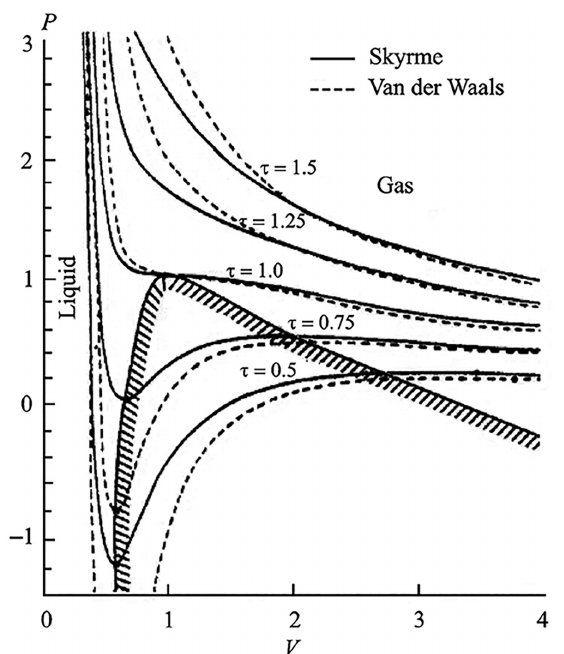
Figure 6. Equations of state P ( V ) for a nuclear system interacting through a Skyrme potential and a Van der Waals compressible liquid–gas system (shown in relative units): qualitative similarity is apparent